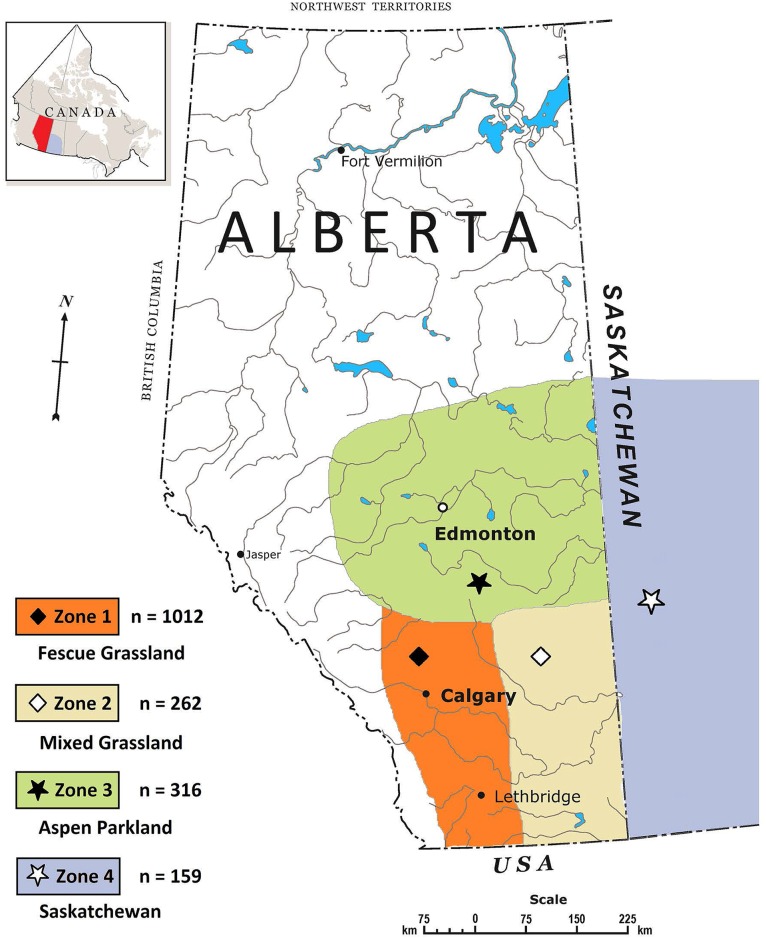
Zones of cattle origin and numbers of samples collected per zone.Zone 1 (n = 1012), fescue grassland; Zone 2 (n = 262), mixed grassland; Zone 3 (n = 316), aspen parkland; Zone 4 (n = 159), Saskatchewan. Reprinted from www.nrcan.gc.ca/earth-sciences/geography/atlas-canada/reference-maps/16846#provincial-and-territorial under a CC BY license, with permission from Natural Resources Canada, original copyright [2004].